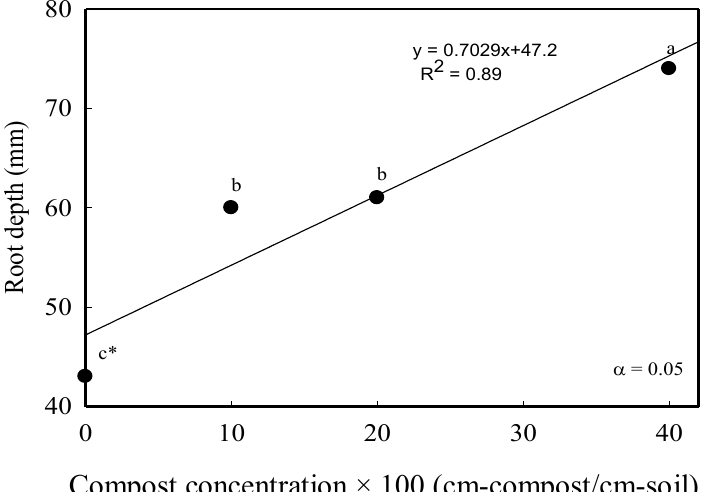
Figure 5. Effect of incorporating composted poultry litter into subsoil on Kentucky bluegrass root depth; * Means with same letters are statistically insignificant based on Fisher’s Protected LSD test ( P ≤ 0.05) (italicized letters correspond to sodded treatments).